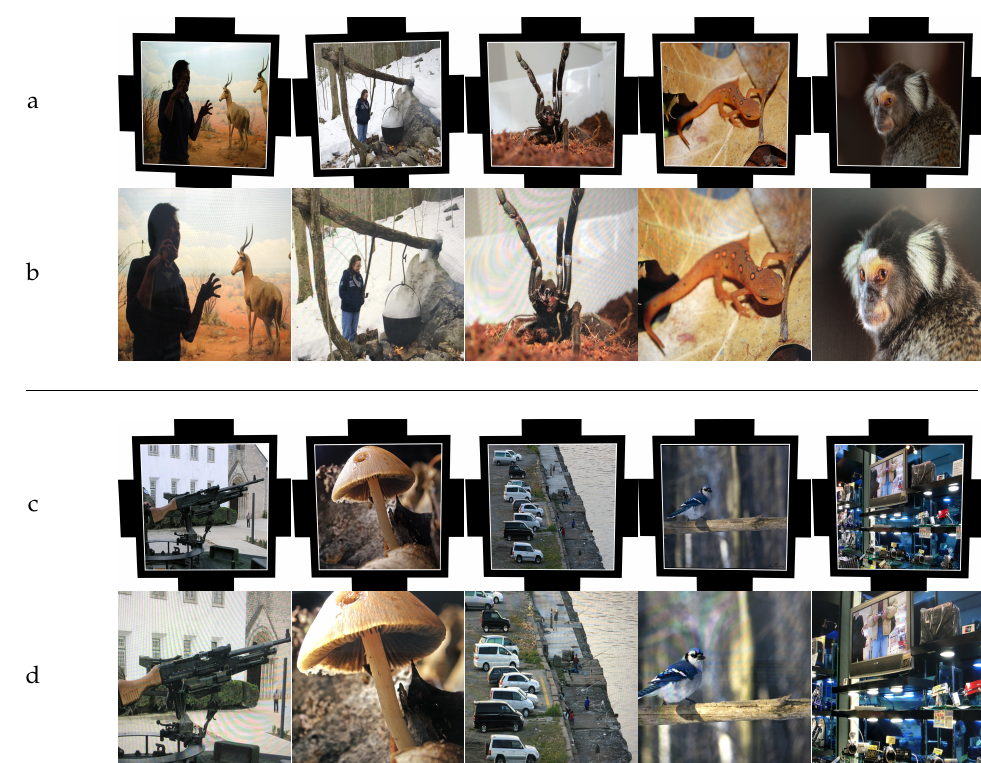
Figure 7. Moiré pattern test results from [38] dataset by the fine-tune network. ( a , c ) pure images; ( b , d ) images (512 × 512) with moiré